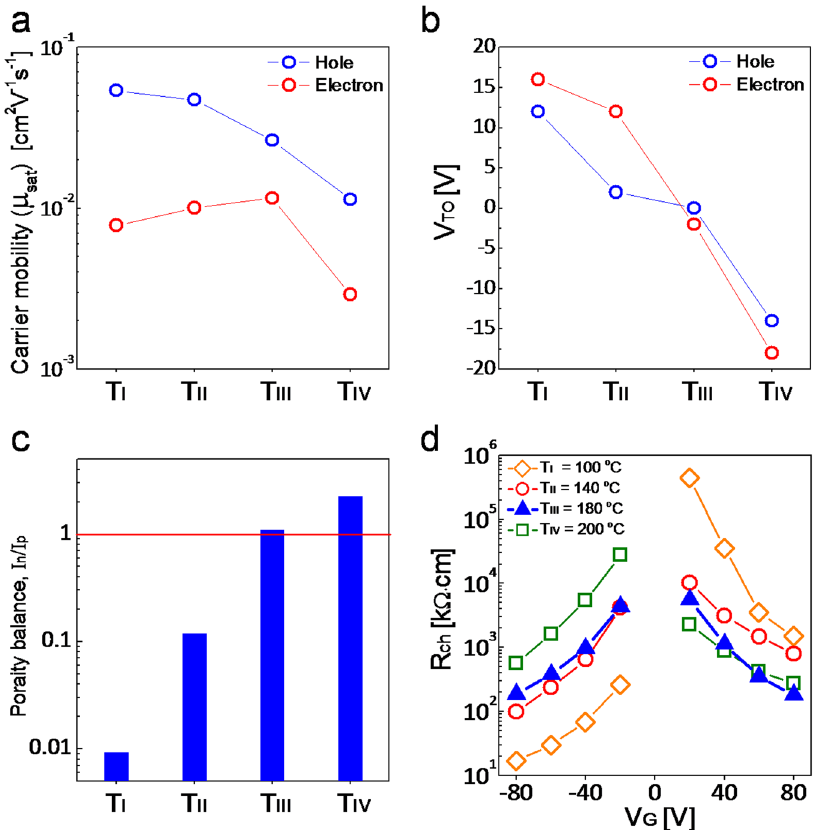
Figure 8. Impact of the vacuum annealing on the transistor electrical properties. ( a ) Extracted saturation mobilities as a function of vacuum annealing condition and ( b ) Turn-on voltage. ( c ) Polarity balance: defined as electron/hole current ratio at |V G | = 80 V. |V D | = 40 V, and |V SIDE | = 60 V. ( d ) Extracted channel resistance of the PDPP3T split-gate ambipolar TFTs. Orange diamond: T I = 100 °C. Red circle: T II = 140 °C. Blue triangle: T III = 180 °C. Green square T IV = 200